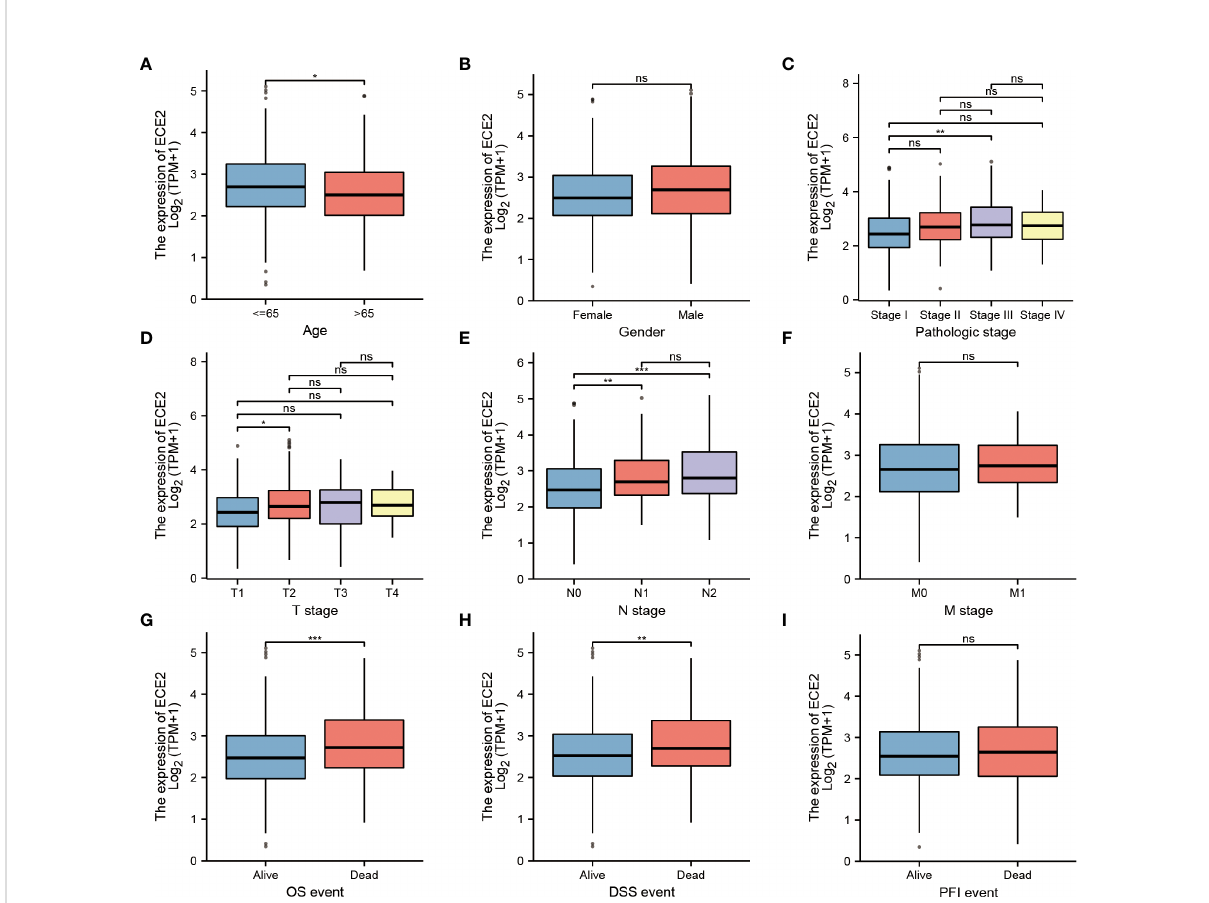
FIGURE 2 Relationship between ECE2 expression and clinicopathological parameters in patients with LUAD. (A) age (Wilcoxon rank sum test), (B) gender (Wilcoxon rank sum test), (C) pathologic stage (One-way ANOVA test), (D) T stage (Kruskal-Wallis Test), (E) N stage (Kruskal-Wallis Test), (F) M stage (Wilcoxon rank sum test), (G) OS event (Wilcoxon rank sum test), (H) DSS event (Wilcoxon rank sum test), (I) PFI event (Wilcoxon rank sum test). (Wilcoxon rank sum test) *P < 0.05; **P < 0.01; ***P < 0.001. ns, not signi fi